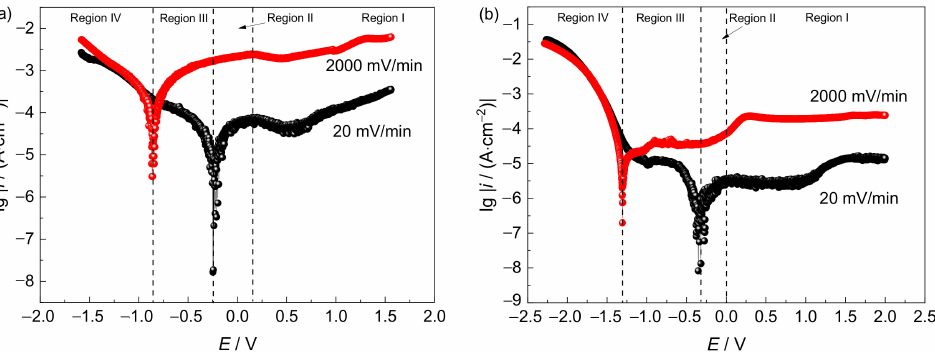
Figure 4. Potentiodynamic polarization curves at different scanning rates in simulated deep − sea ( a ) and shallow − sea ( b )